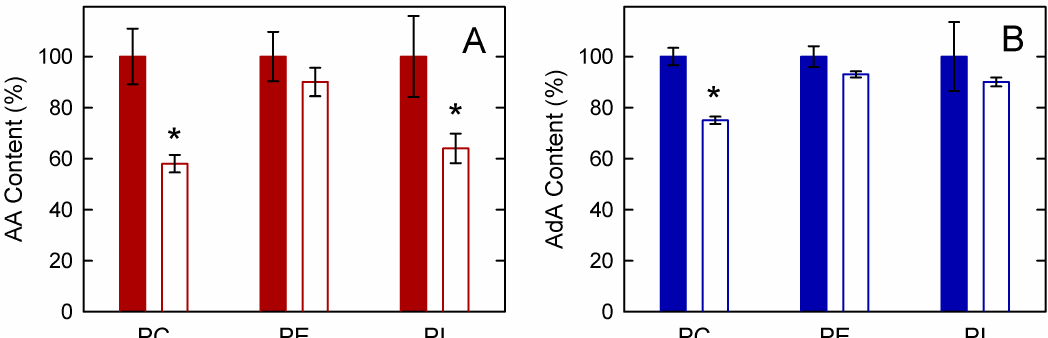
Figure 3. AA and AdA mobilization in zymosan-stimulated macrophages. The cells were unstimulated (colored bars) or stimulated (open bars) with 1 mg/mL zymosan for 1 h. Afterward, total content of AA ( A ) or AdA ( B ) in various phospholipid classes (see x-axis) was measured by GC/MS. To allow for direct comparison between AA and AdA, the fatty acid contents in phospholipid classes in unstimulated cells are given as 100%. Actual mass values can be obtained from Figure 1. Results are shown as mean values ± standard error of the mean. ( n = 3). Note: * p < 0.05, significantly different from the corresponding phospholipid class.